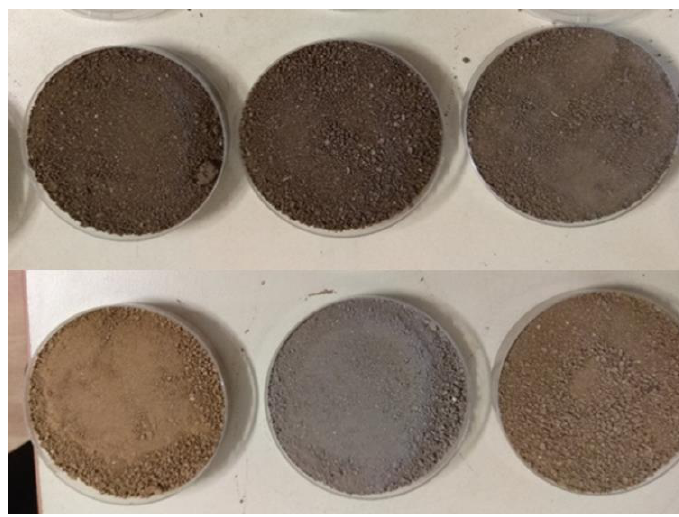
Figure 2. Different soil samples taken from the study area.